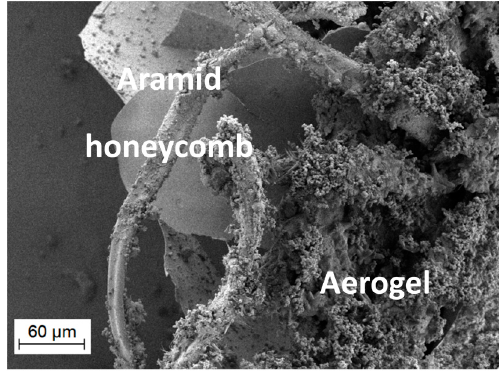
Figure 10. SEM image (magnification 208×) of a cut-off cross-section of the SA1 aerogel-honeycomb composite, showing aramid-fibers, covered with good adhering aerogel particles.